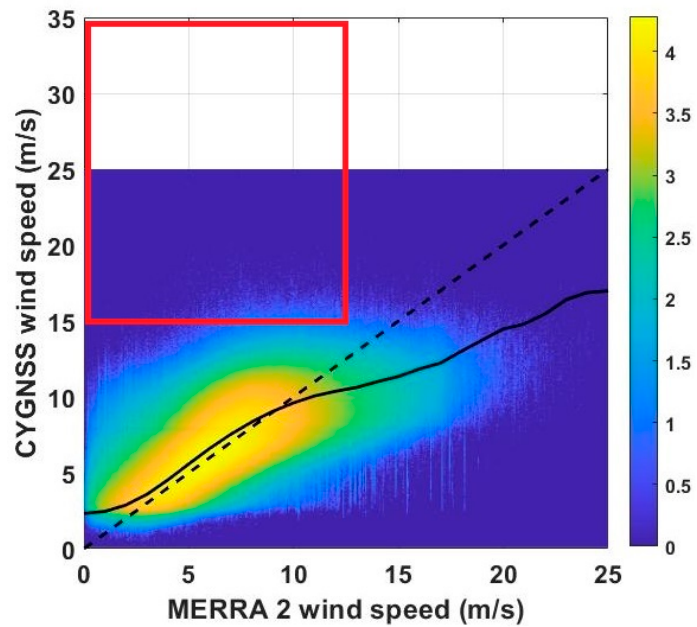
Figure 6. CYGNSS retrieved wind dataset after quality control. The outliers in the red box have been mostly eliminated here relative to Figure 1.